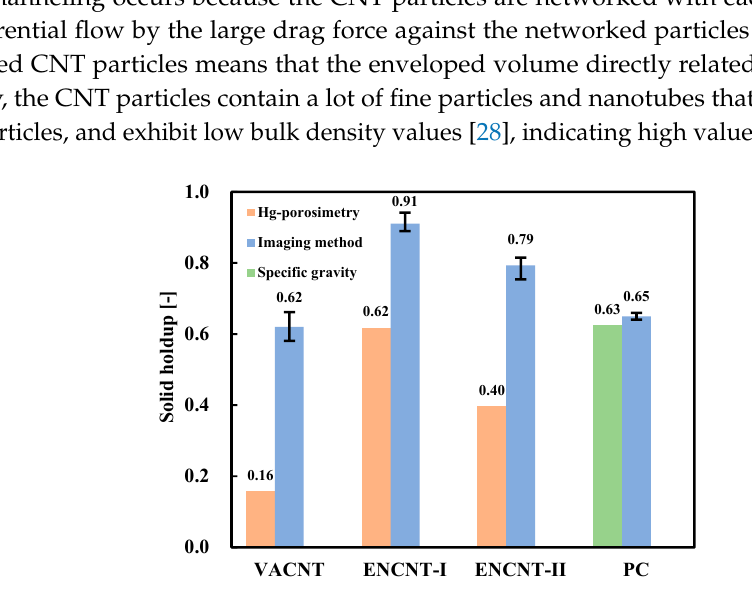
Figure 8. Comparison of solid holdup values of a loosely packed bed .